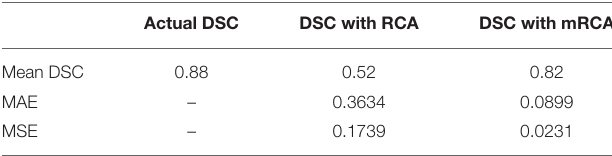
FIGURE 6 | Examples of image quality assessment comparing RCA and mRCA methods. The “Good” ( η ∈ [0 0.2]), “Average” ( η ∈ [0.2 0.5]), and “Poor” ( η ∈ [0.5 1.0]) refer to the quality of the predictions of the RCA method when compared to the actual DSC scores in terms of the relative error (not shown on the figure), where relative error η = ( DSC actual − DSC predicted ) / DSC actual ). (cid:12) (cid:12) (cid:12) (cid:12) TABLE 10 | Mean of actual DSC and predicted DSC for RCA and mRCA methods with MAE and MSE results for 2,000